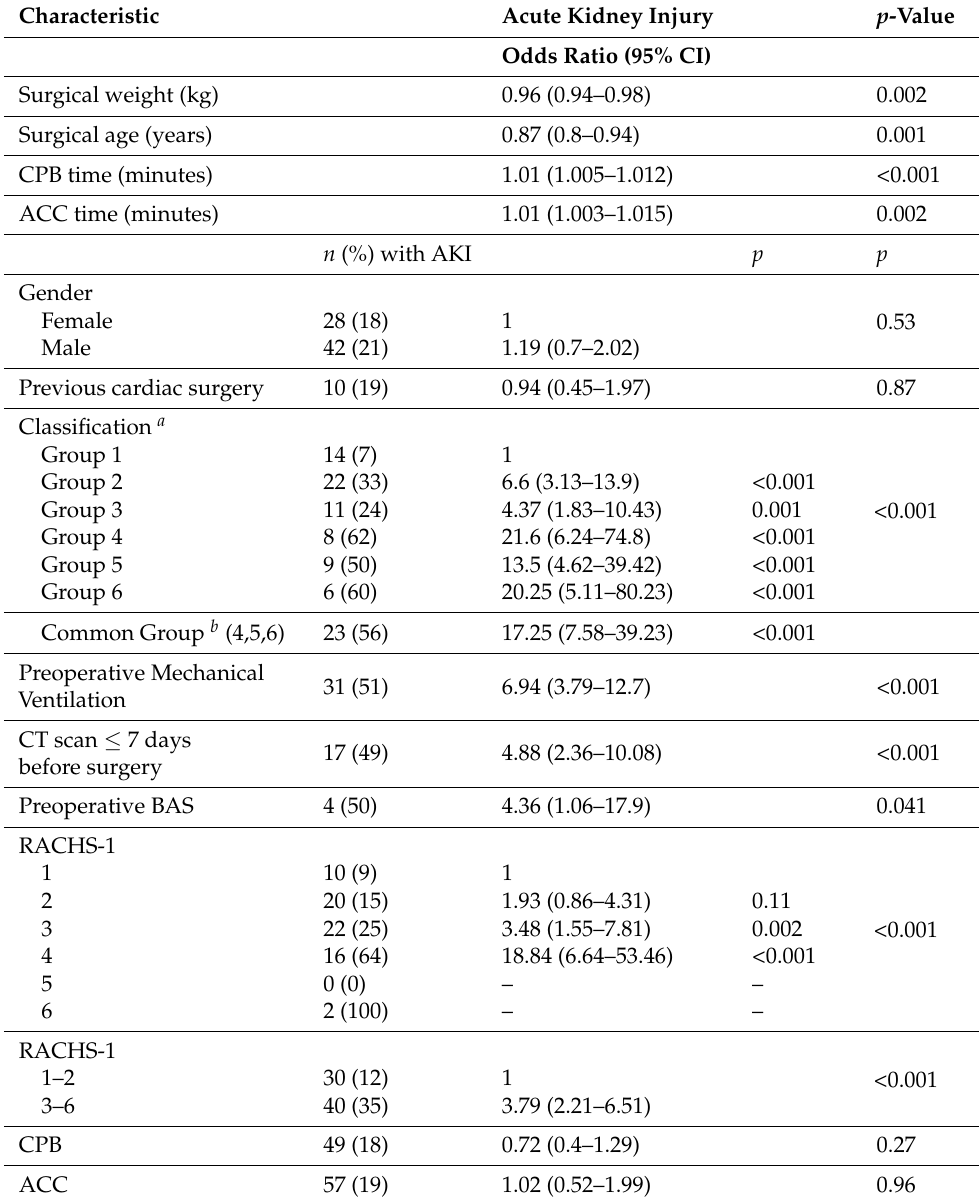
Table 3. Univariate logistic regression ( n =